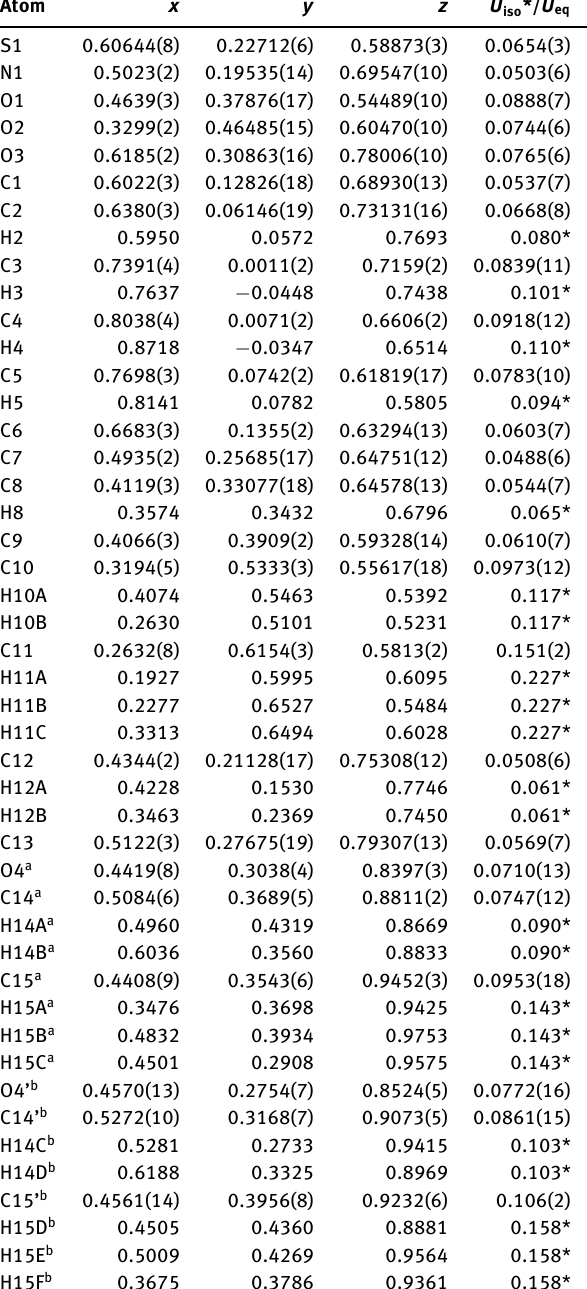
Table 2: Fractional atomic coordinates and isotropic or equivalent isotropic displacement parameters (Å 2